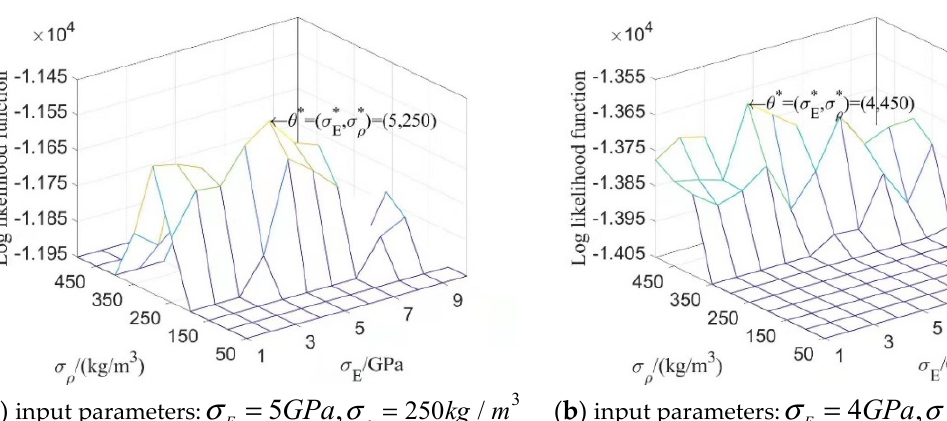
Figure 8. Log likelihood function of 8-dimensional kernel density distribution function of the first 8 orders’ natural frequencies when both E and ρ are random fields.